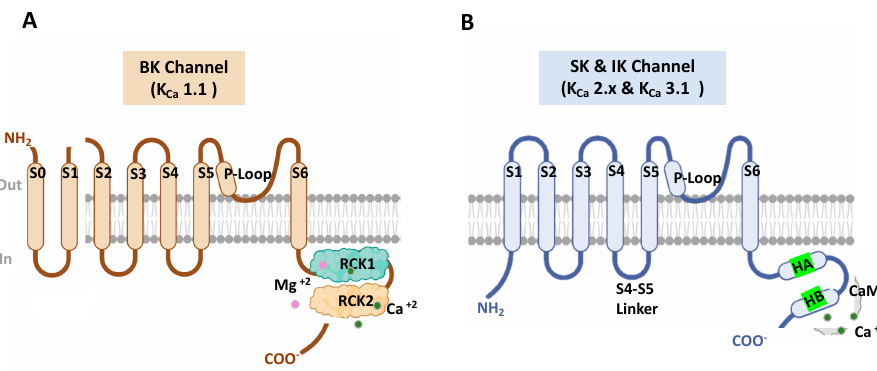
Figure 2. Diagram of the general K Ca 1.1 and K Ca 2.x channel structure. ( A ) Schematic channel topology of one K Ca 1.1 α -subunit, including the pore-gate domain between (S5–S6) and a C-terminal cytosolic region that functions as a Ca 2+ sensor constituted by two non-identical domains (RCK1 and RCK2), which contain high-affinity binding Ca 2+ sites (Ca 2+ bowl) and several domains for multiple ligands or cations such as Mg 2+ . ( B ) Schematic channel topology of one K Ca 2.x α -subunit, including the CaM that serves as the K Ca 2.x and K Ca 3.1 channel’s Ca 2+ sensor. A and B were generated using Biorender.com.